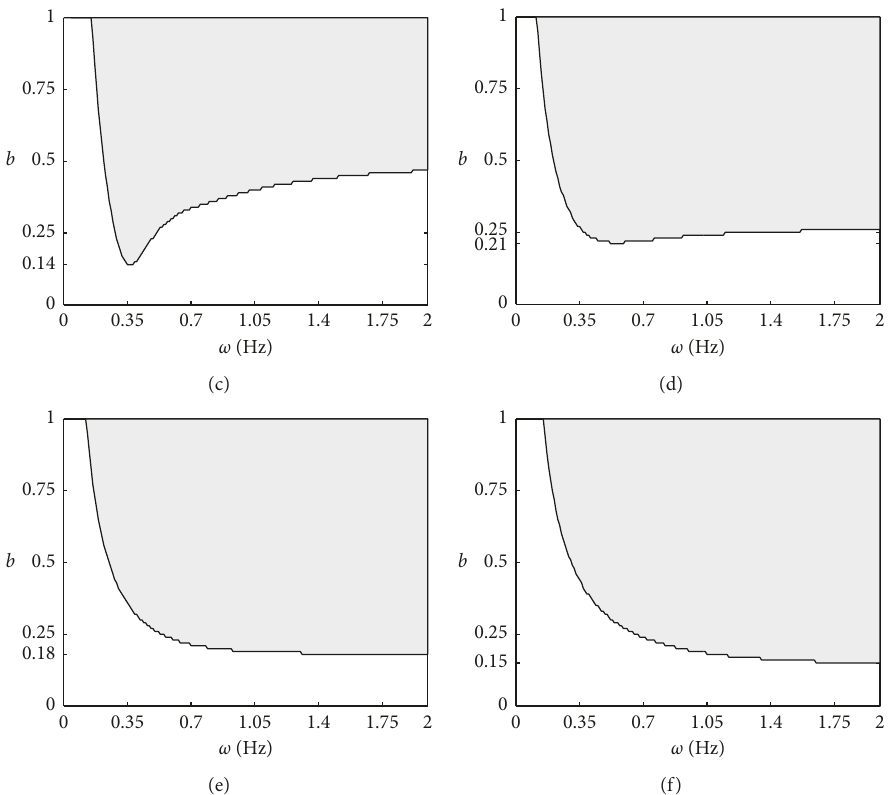
Figure 3: Mean square stability charts to equation (8) for the values η